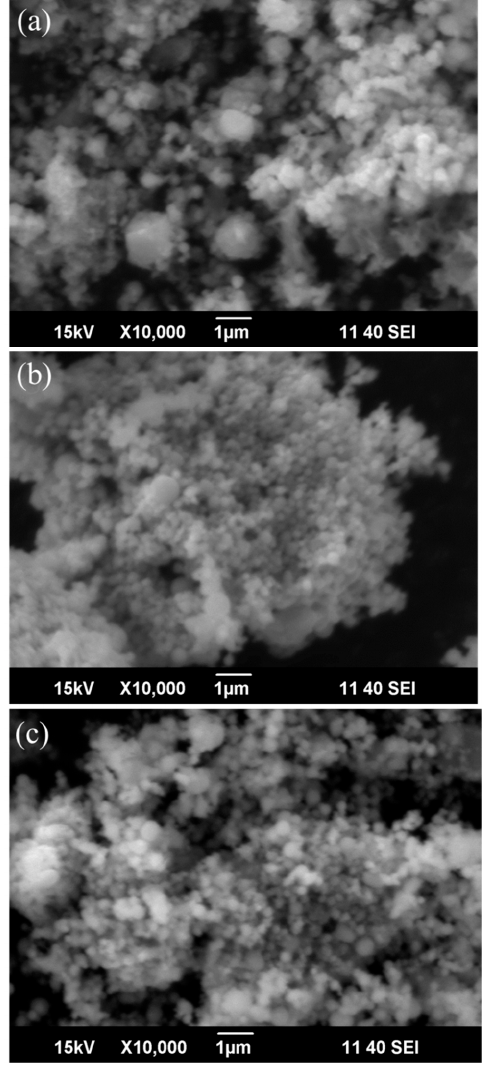
Figure 8. SEM micrographs of the corresponding leaching residues. ( a ) Residue of BOS-1; ( b ) Residue of BOS-2; ( c ) Residue of BOS-3. of BOS-2; ( c ) Residue of